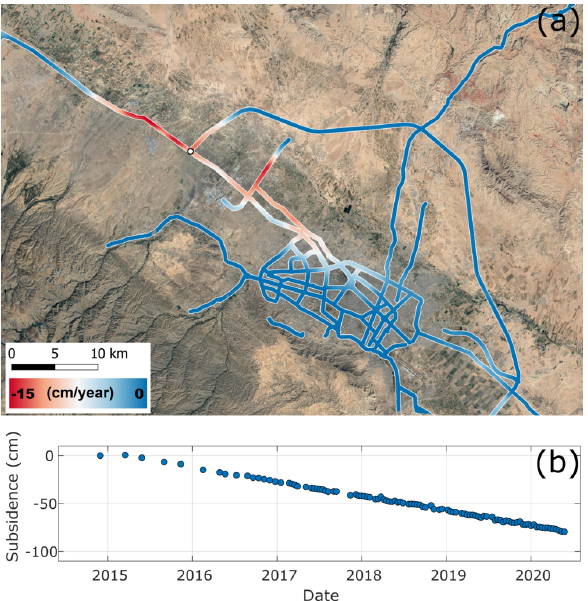
Figure 8. High-resolution analysis of subsidence for monitoring roads and highways in Mashhad. (a) average rate of subsidence along major roads and highways. (b) Time series of subsidence for a point, at the intersection of Mashhad northern freeway and Quchan road, indicated by white circle in (a). Background imagery for (a) Google Earth Landsat/Copernicus, Map data Figure 7. High-resolution analysis of subsidence for monitoring ©2021 railways and metro lines in Mashhad. (a) average rate of subsidence along railways and metro lines. Black circles A 6 to 12 day acquisition interval of new Sentinel-1 data indicate stations along metro line 2. (b) profile of displacement rate along metro line 2 from Tabarsi station in the northeast to Salamat station in the southwest. Circles indicate metro stations along this line. (c) profile of displacement rate along Mashhad-Tehran Railway. The circle indicates Mashhad Central Station. Background imagery for (a) Google Earth Landsat/Copernicus, Map data ©2021